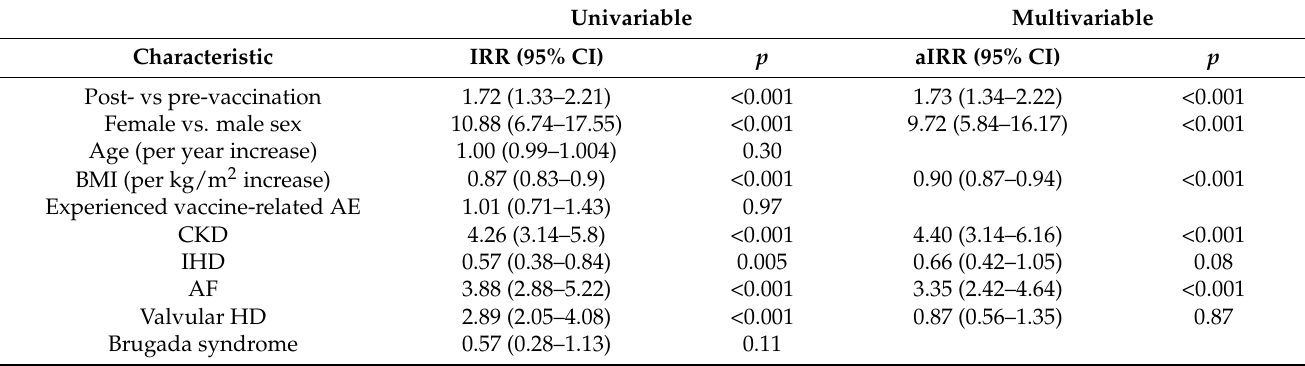
Table 4. Univariable and multivariable incidence rate ratios for SVT. (aIRR; adjusted incidence rate ratio. IRR; incidence rate